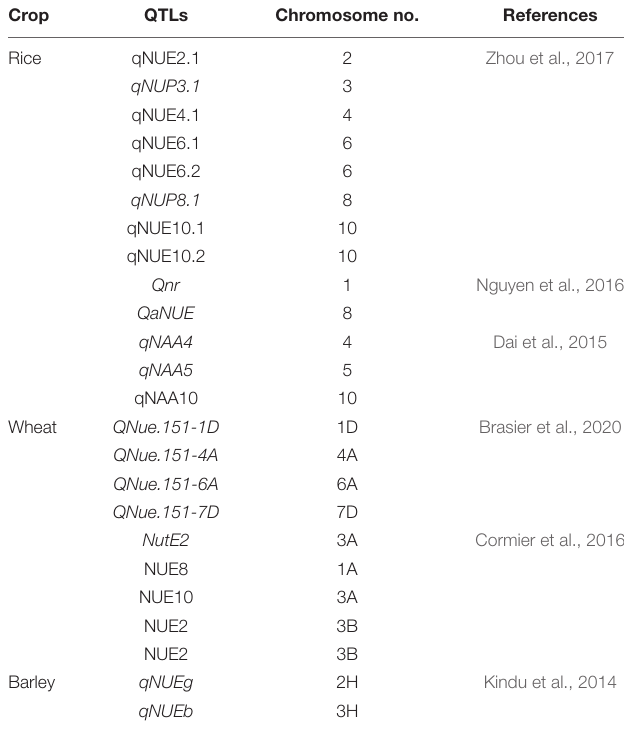
TABLE 2 | Major quantitative trait loci (QTL) associated with NUE in cereals crops. Crop QTLs Chromosome